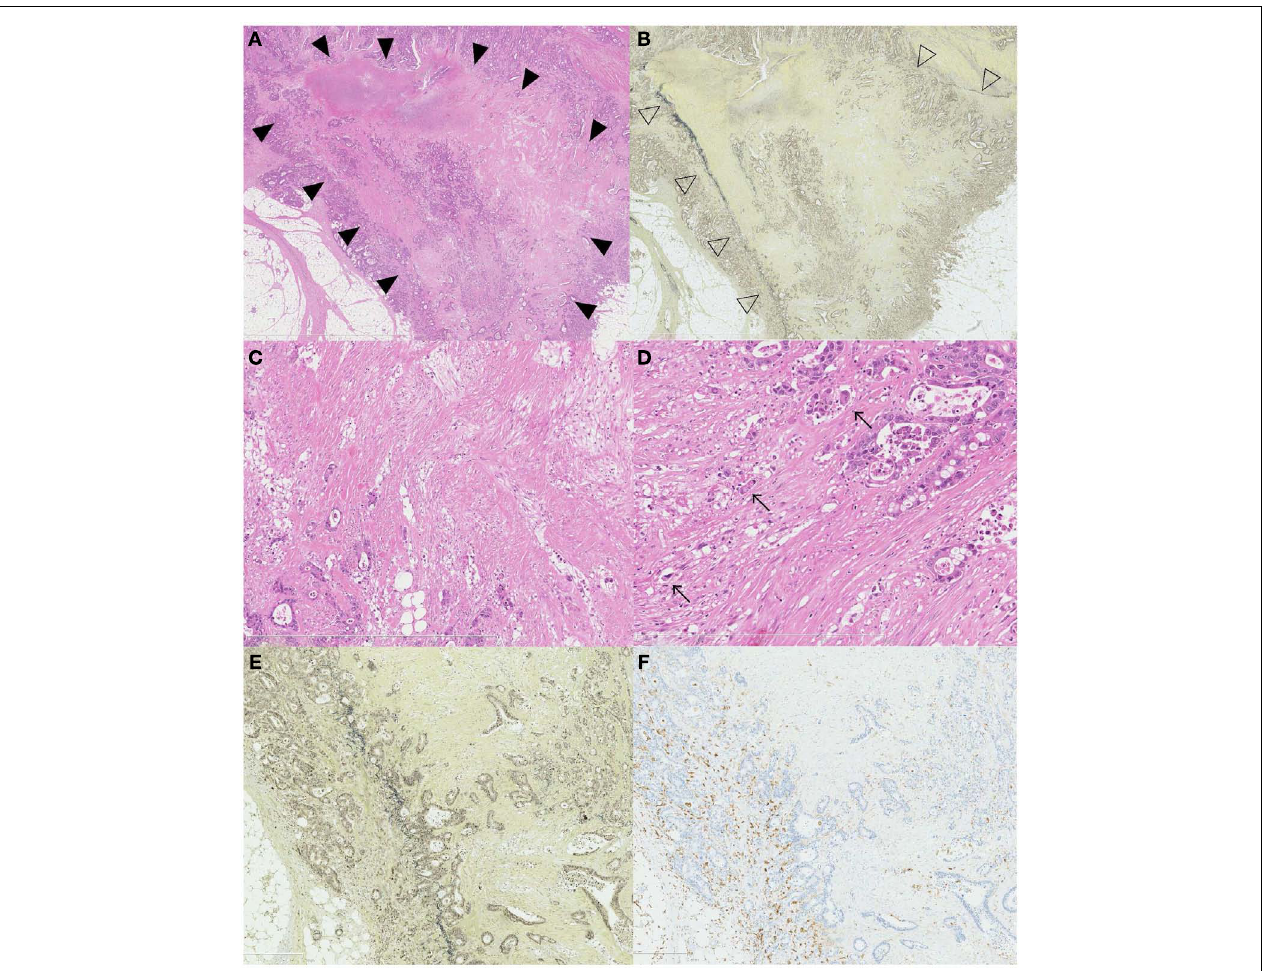
The distribution of CD204-positive macrophages and an association with the ELI and fibrotic focus is seen in (E,F) . CD204-positive macrophages are distributed along the periphery of the fibrotic focus (E) and along the peritoneal elastic lamina (F)